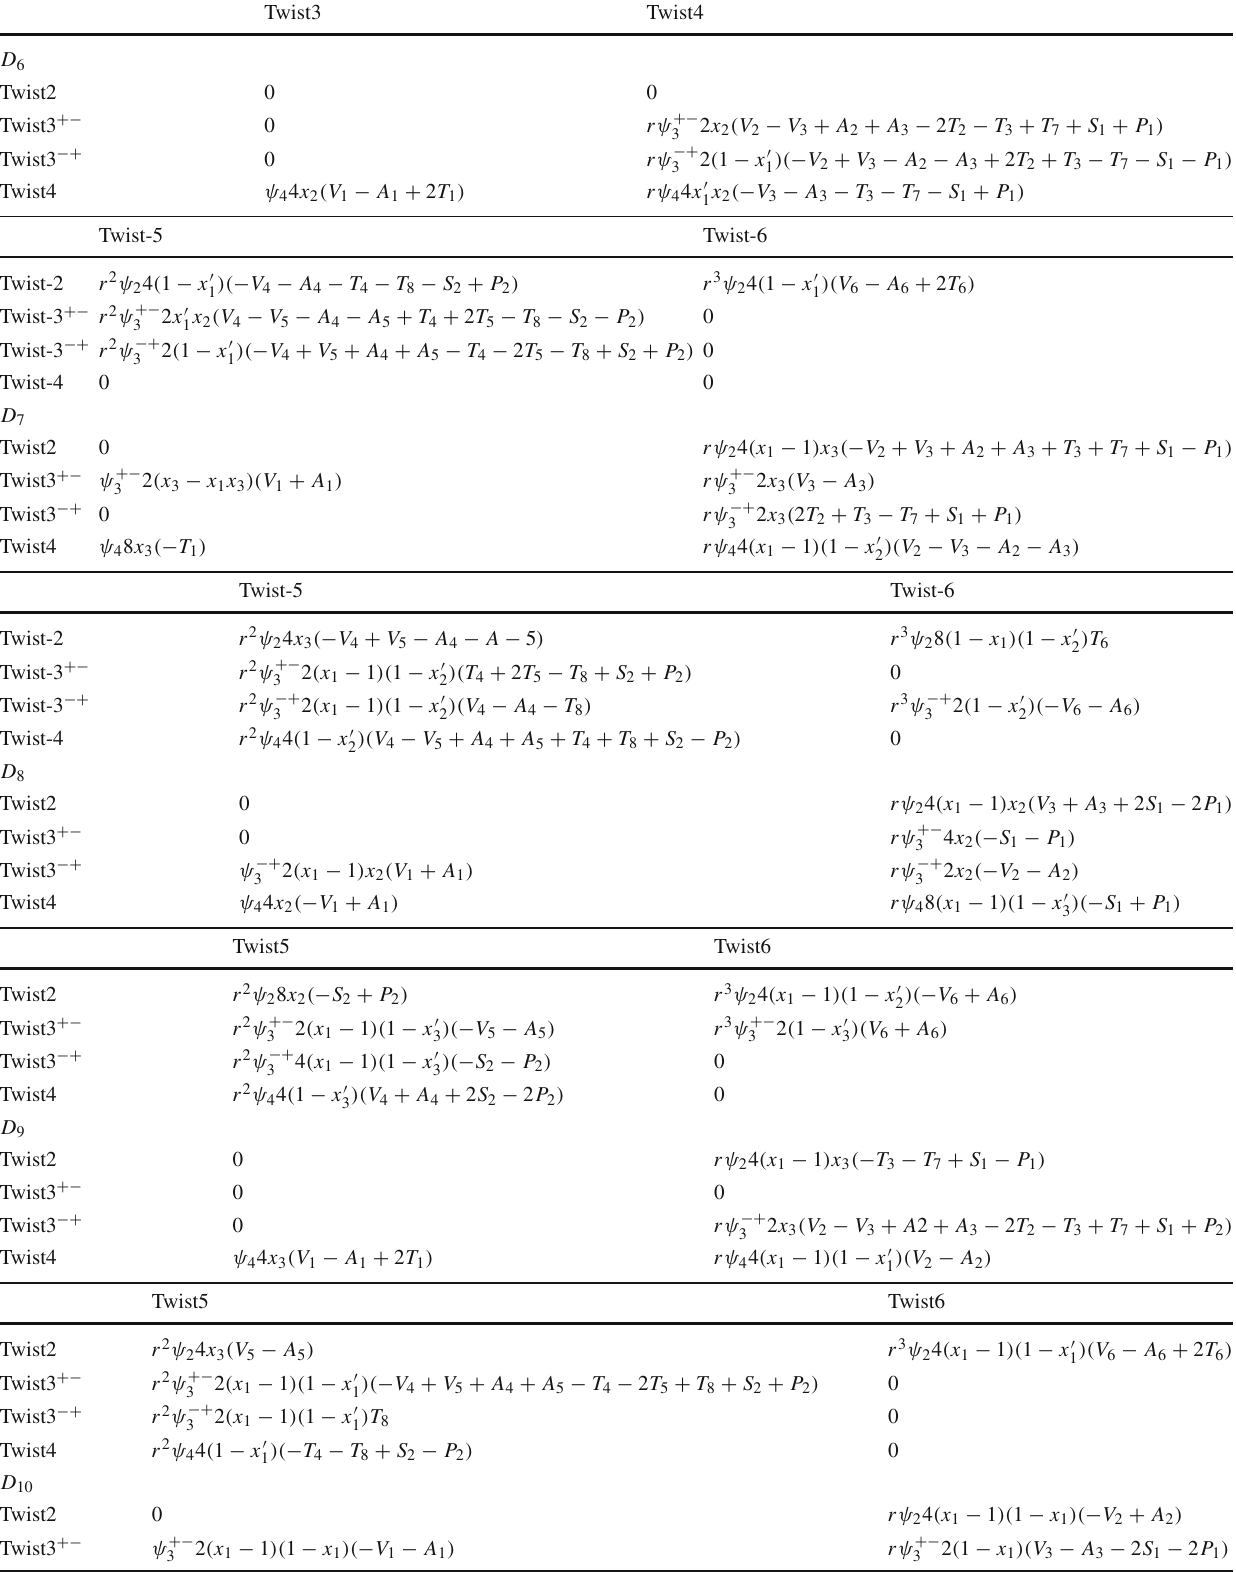
Table 15 The same as Table 5 but for the diagrams D 6 , D 7 , D 8 , D 9 and D 10 in Fig. 1 Twist3